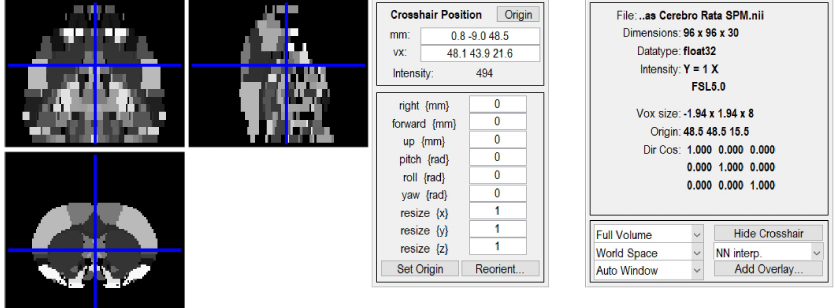
Figure 2. Statistical Parametrical Mapping toolbox. The image represents a slice of the employed digital atlas, whereas the specific coordinates are shown in SPM